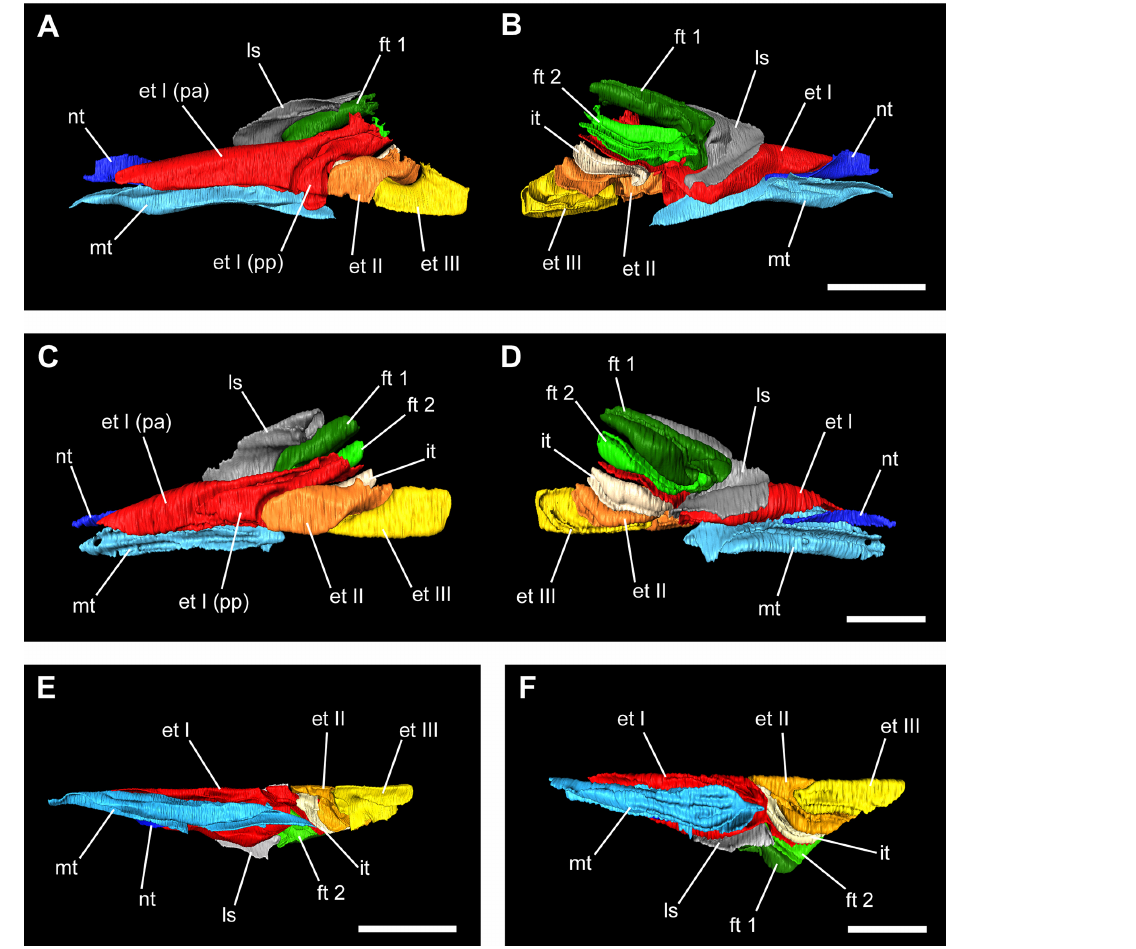
Figure 4. Virtual three-dimensional models of the right adult turbinal skeleton of (a , b , e) Ptilocercus lowii (ZMB 3992) and (b , c , f) Tupaia sp. (collection W. Maier): (a) and (c) medial view, (b) and (d) lateral view, (e) and (f) ventral view. Abbreviations: et I, II, III, ethmoturbinal I, II, III; ft 1, 2, frontoturbinal 1, 2; it, interturbinal; ls, lamina semicircularis; mt, maxilloturbinal; nt, nasoturbinal; pa, pars anterior; pp, pars posterior. Scale bars equal